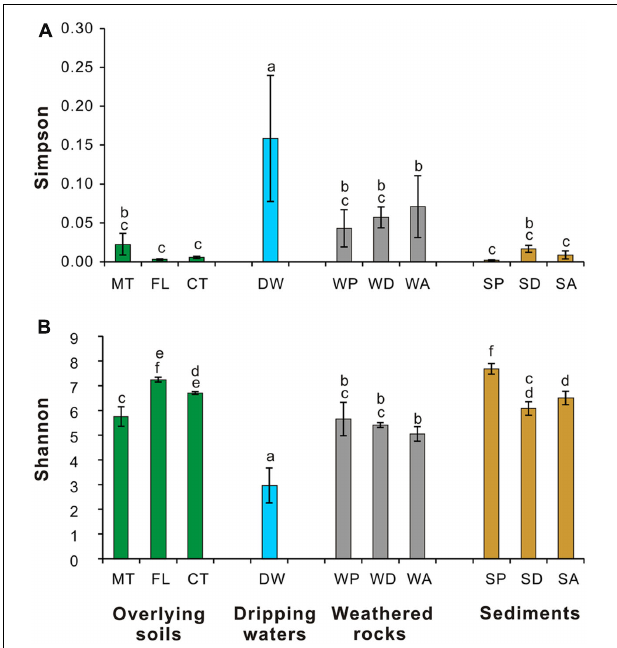
FIGURE 4 | Simpson (A) and Shannon (B) indices of 16S rRNA genes from microbial communities in different habitats at Heshang Cave. See methods for description of the one-way ANOVA (analysis of variance) calculations. Different letters (a–f) above the bars showed significantly difference ( P < 0.05) among each habitat according to Duncan’s multiple range test. Sample colors are the same as those in previous figures, and abbreviations described in Figure 1